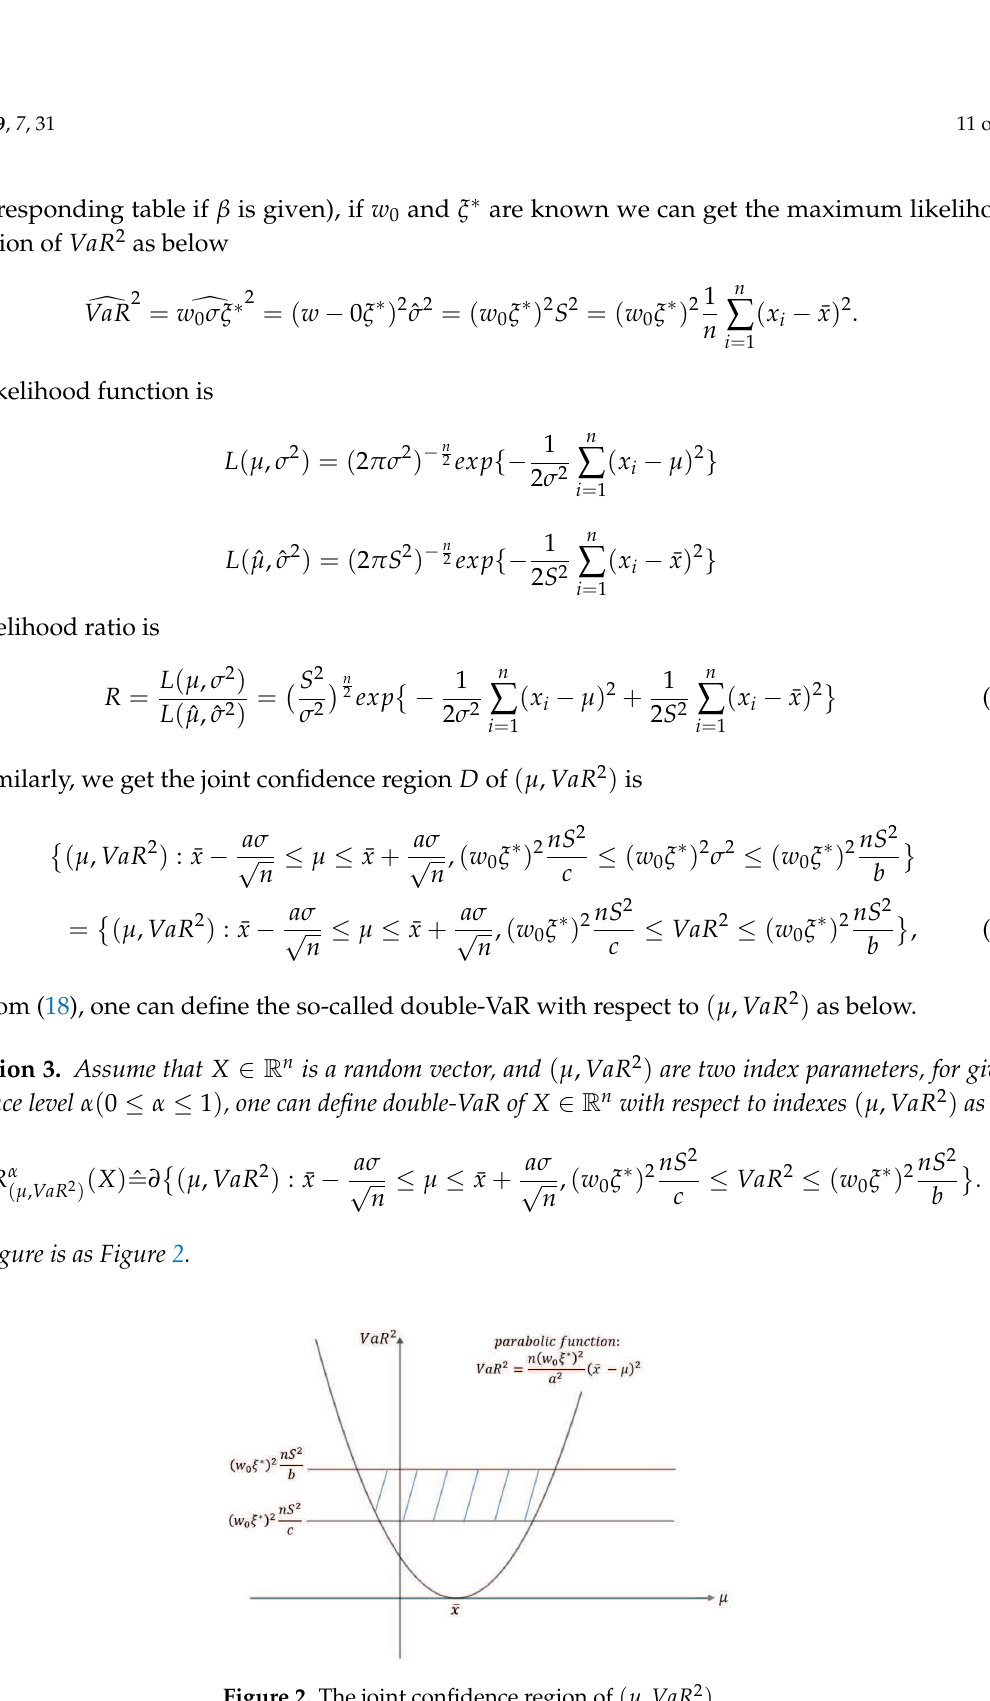
Figure 2. The joint confidence region of ( µ , VaR 2 )